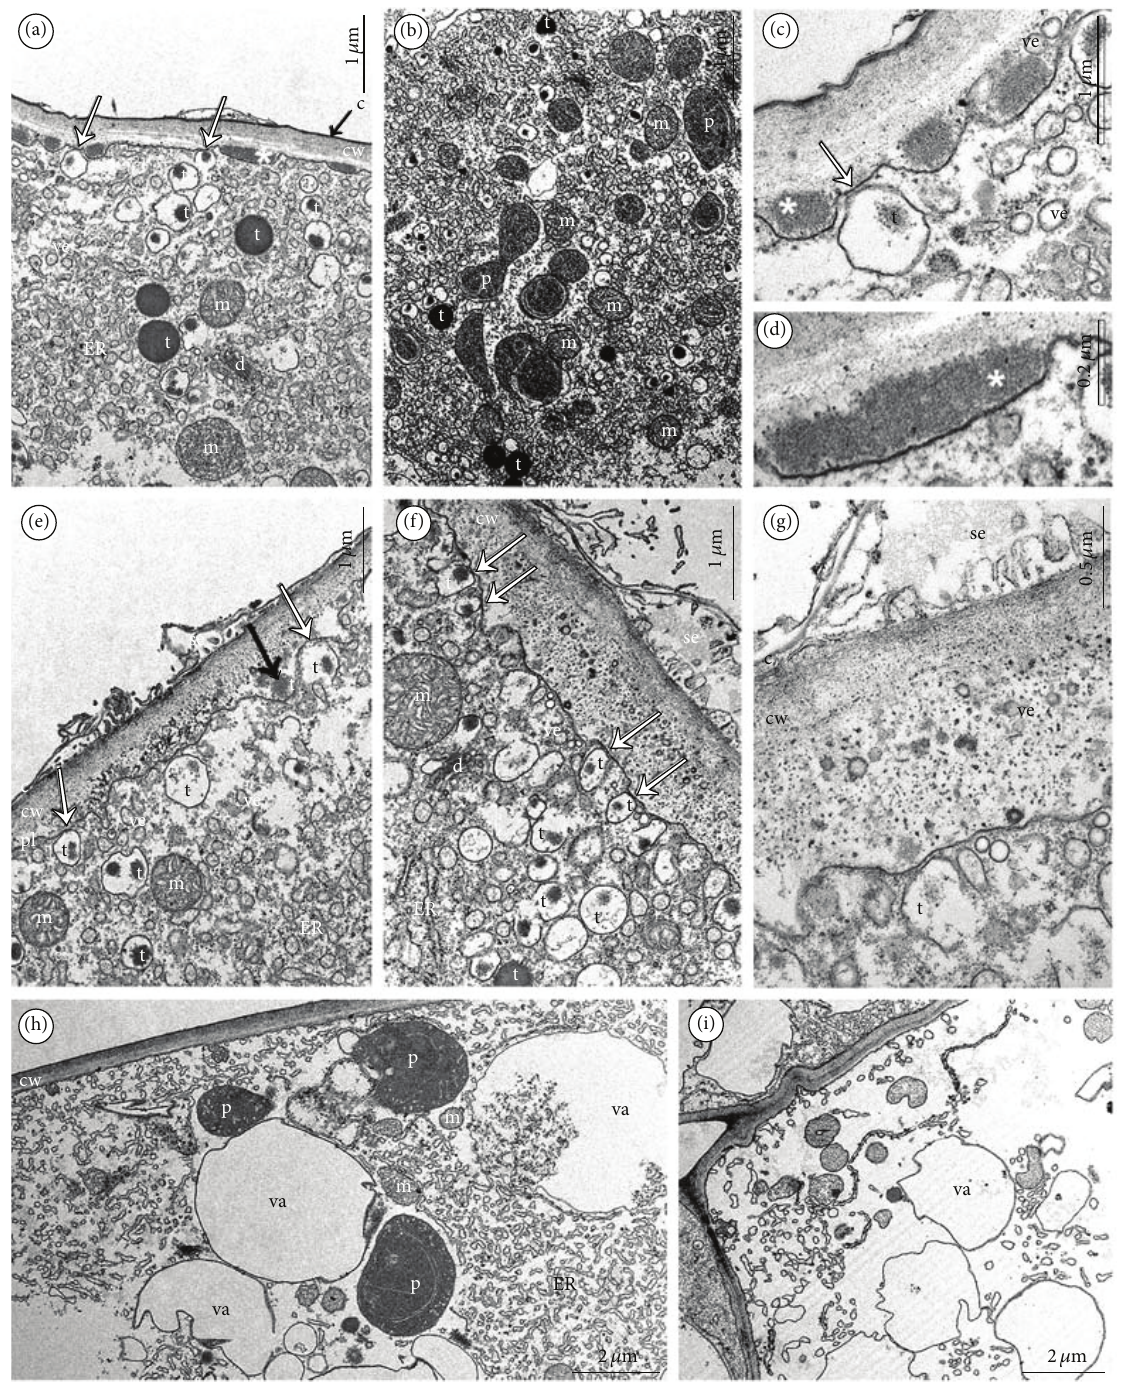
Figure 4: Ultrastructure of papillae (TEM). (a) Dense cytoplasm with profuse rough or smooth endoplasmic reticulum, plentiful vesicles (bigger ones with tannin-like materials), numerous mitochondria, and dictyosomes. Notice the vesicles with tannin-like materials in contact with plasmalemma ( white arrows ) and structurally the same electron-dense bodies ( asterisks ) in cell wall. The thin layer of swelled cuticle ( black arrow ). (b) Dense cytoplasm of papillae with spherical mitochondria, plastids with tubular structures, and tannin-like materials. (c) Magnificationof(a),vesiclewithtannin-likematerialsincontactwithplasmalemma( whitearrows ),theelectron-densebodies( asterisk )incell wall, thin layer of cuticle, small vesicles present in cytoplasm and in cell wall. (d) Magnification of (a), the electron-dense body ( asterisk ) in cell wall. (e, f) In cytoplasm plentiful vesicles are present. (bigger ones with tannin-like materials). Notice the vesicles with tannin-like materials in contact with plasmalemma ( white arrows ) and structurally the same electron-dense body ( black arrow ) after building into plasmalemma. The ruptured, thin layer of swelled cuticle caused by pressure of gathered substances. (g) Cell wall structure with visible numerous vesicles and secretion gathered under the cuticle. (h, i) More vacuolated (va: vacuole) cells of outgrowth under the papillae with starchless plastids with tubular structures (c: cuticle, cw: cell wall, d: dictyosomes, ER: profiles of endoplasmic reticulum, m: spherical mitochondria, p: plastids, pl: plasmalemma, se: secretion, t: tannin-like materials, and ve: